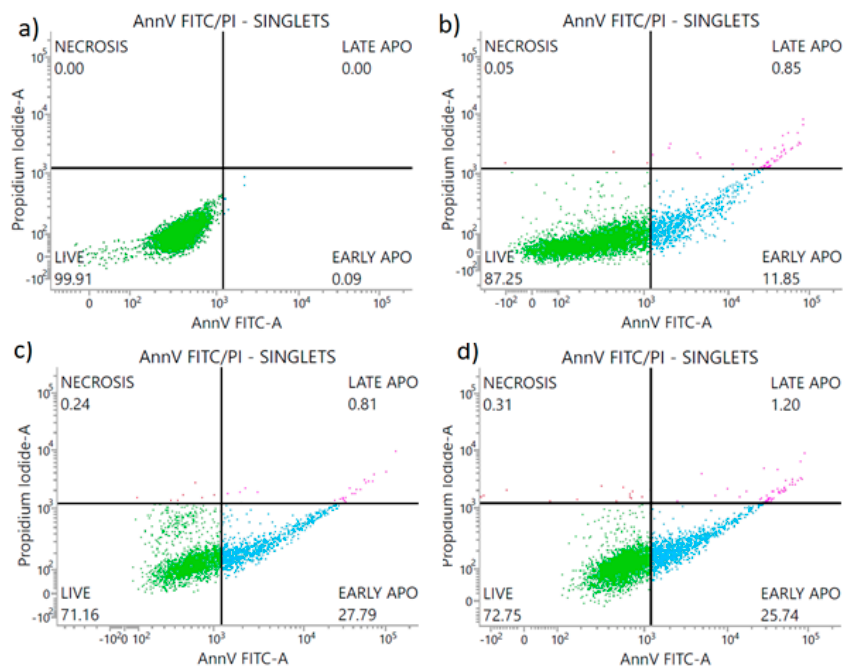
Figure 8. Percentage share of the L929 cells: alive, early apoptotic, late apoptotic and necrotic, after 24 h treatment with: ( a ) DMEM—control group; ( b ) 24 h extract of pure PA12; ( c ) 24 h extract of PA12 with 3 wt % of metal oxides; ( d ) 24 h extract of PA12 with 4 wt % of metal oxides. The experiment was performed in triplicate.